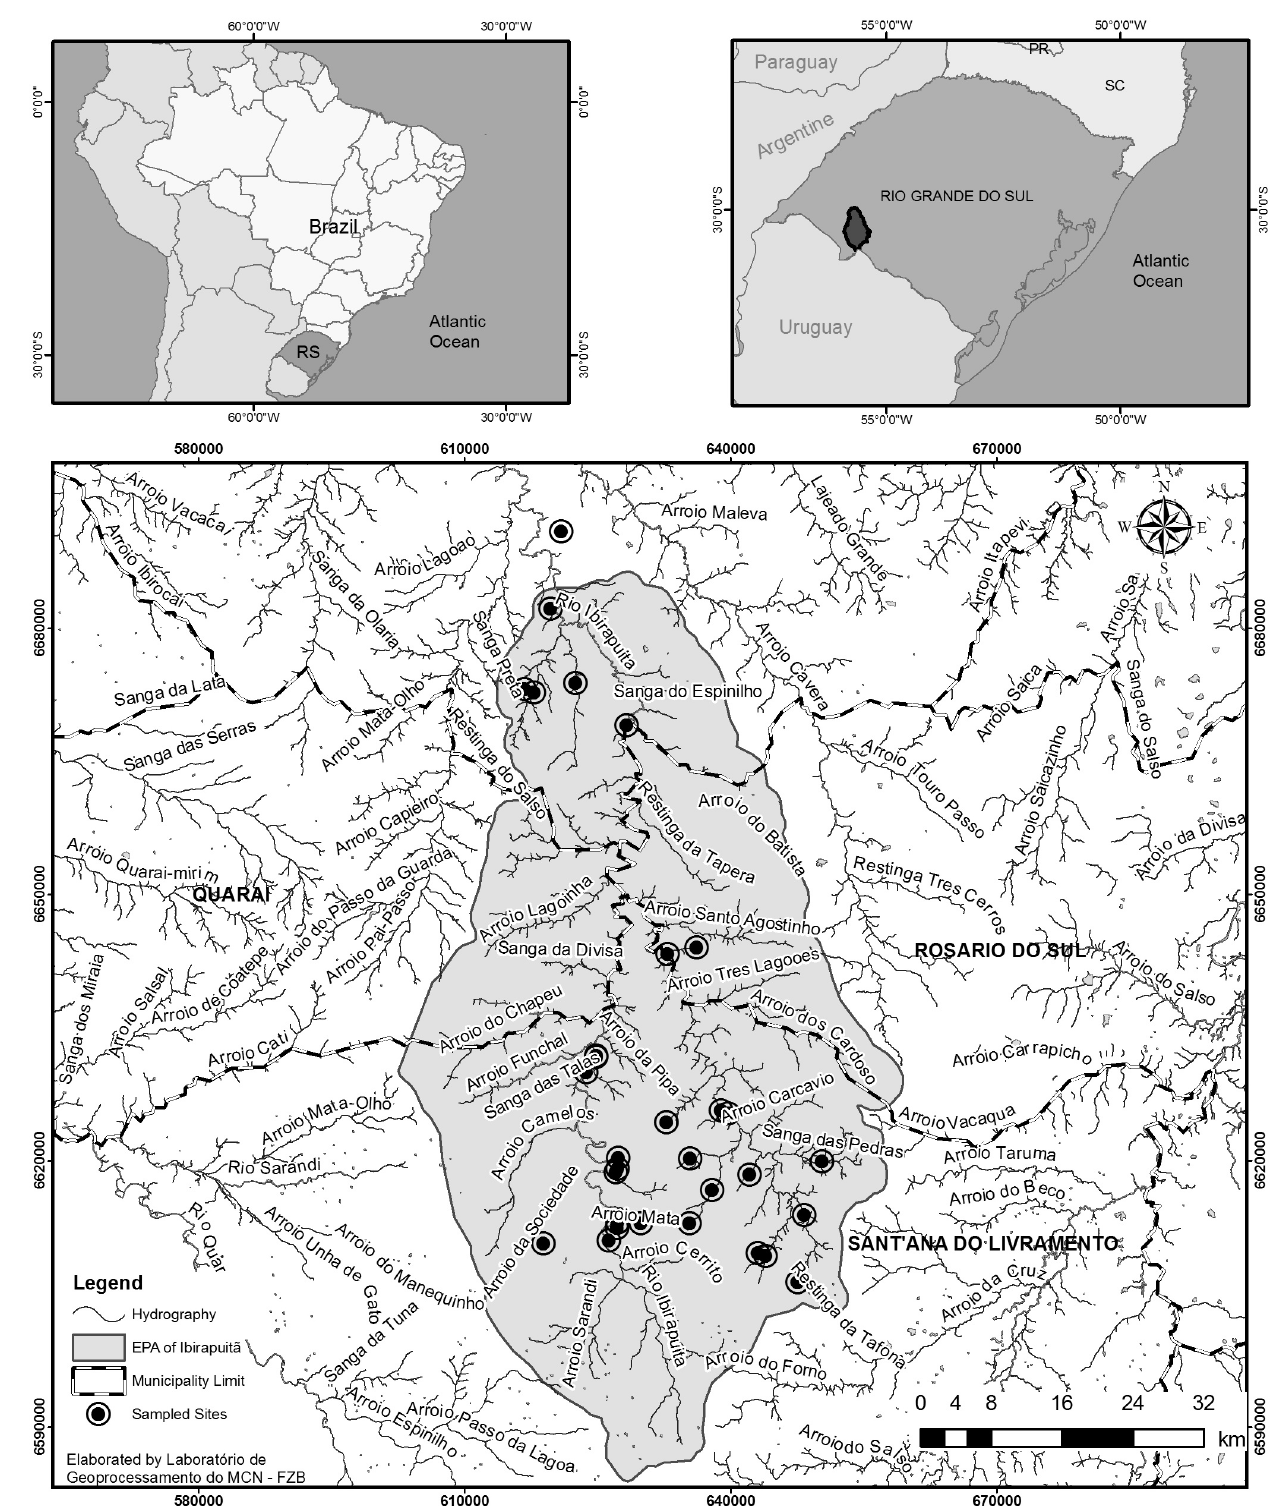
Map of the studied area showing the collection sites in the rio Ibirapuitã basin, Environmental Protection Area of Ibirapuitã, Rio Grande do Sul State, Brazil. PR = Paraná State, SC = Santa Catarina State. Some points (black circles) on the map may be superimposed due to the proximity of the sampled